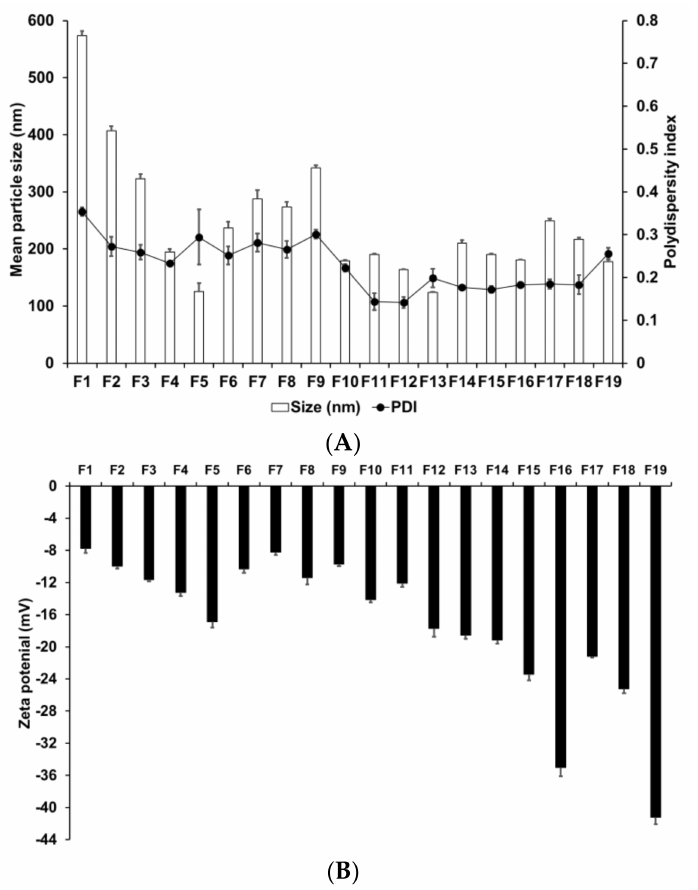
Figure 1. Physicochemical characteristics (average particle size, polydispersity index (PDI), and zeta potential) of adenosine-loaded solid lipid nanoparticles (SLNs). Results are expressed as the means ± standard deviations of three independent experiments ( n = 3). ( A ) Particle size and PDI and ( B